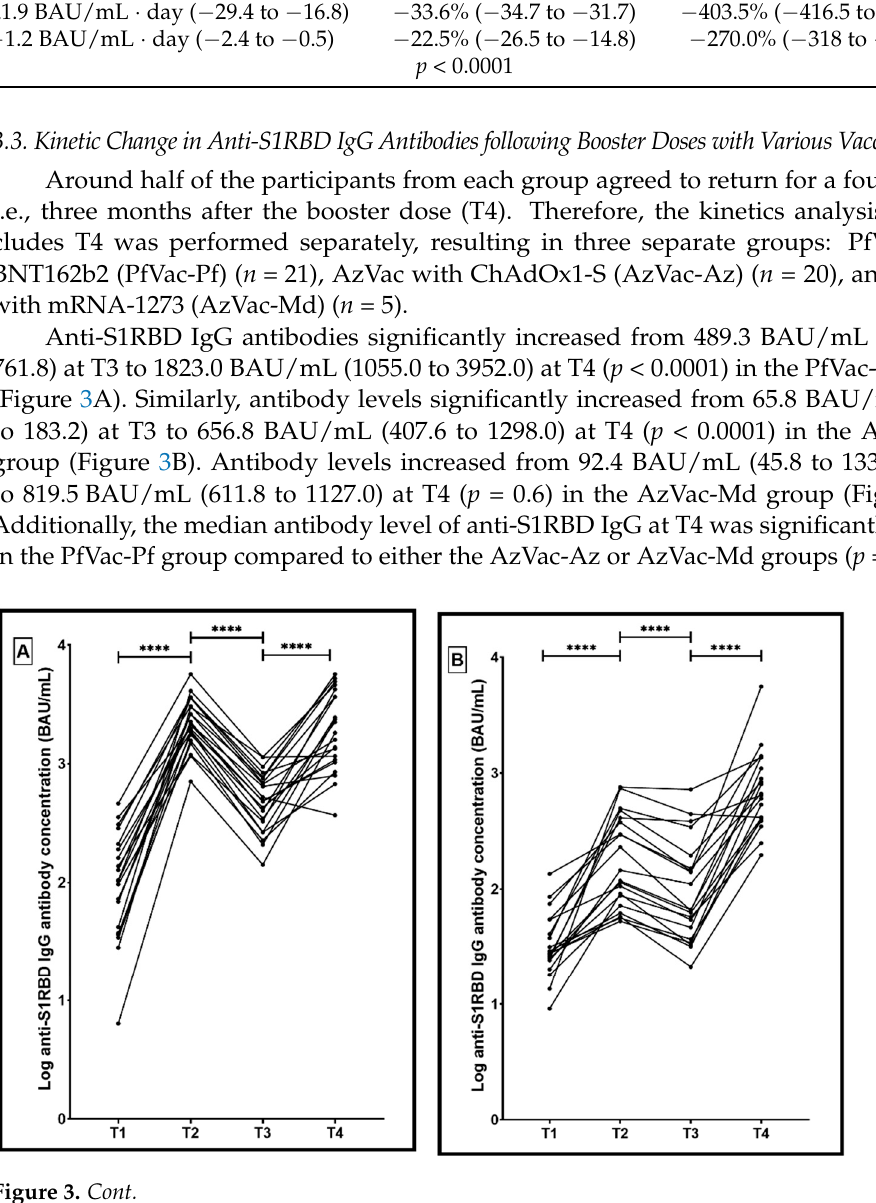
Figure 3. ( A ) Correlation graph representing the change in anti-S1RBD IgG antibody concentrations in participants vaccinated with three doses of BNT162b2 (PfVac-Pf) across four time points; 3 weeks after the first vaccination dose (T1), 3 weeks after the second dose (T2), 3 months after the second dose (T3), and 3 months after the booster dose. ( B ) Correlation graph representing the change in anti-S1RBD IgG antibody concentrations in participants vaccinated with three doses of ChAdOx1- S (AzVac-Az) across four time points; 12 weeks after the first vaccination dose (T1), 3 weeks after